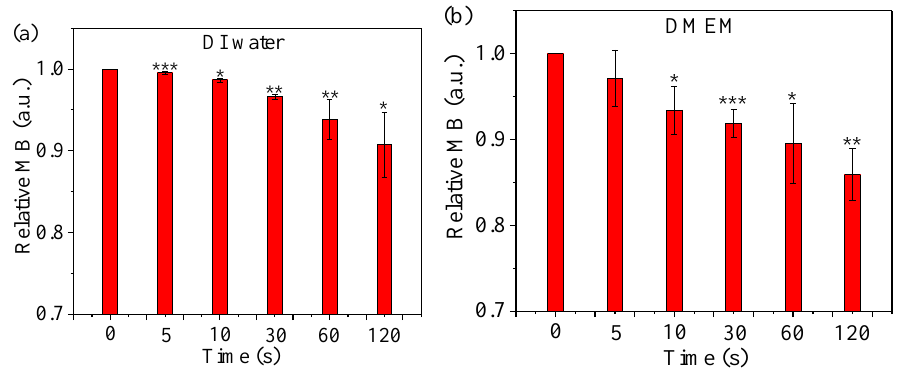
Figure 4. Cont . Figure 4. Relative methylene blue (MB) concentration for assessing the concentration of hydroxyl free radicals in He µCAP-treated DI water ( a ) and DMEM ( b ). Student t -test was performed, and the statistical significance compared to MB without µCAP treatment (0 s) is indicated as * p < 0.05, ** p < 0.01, *** p < 0.001. ( n = 3).